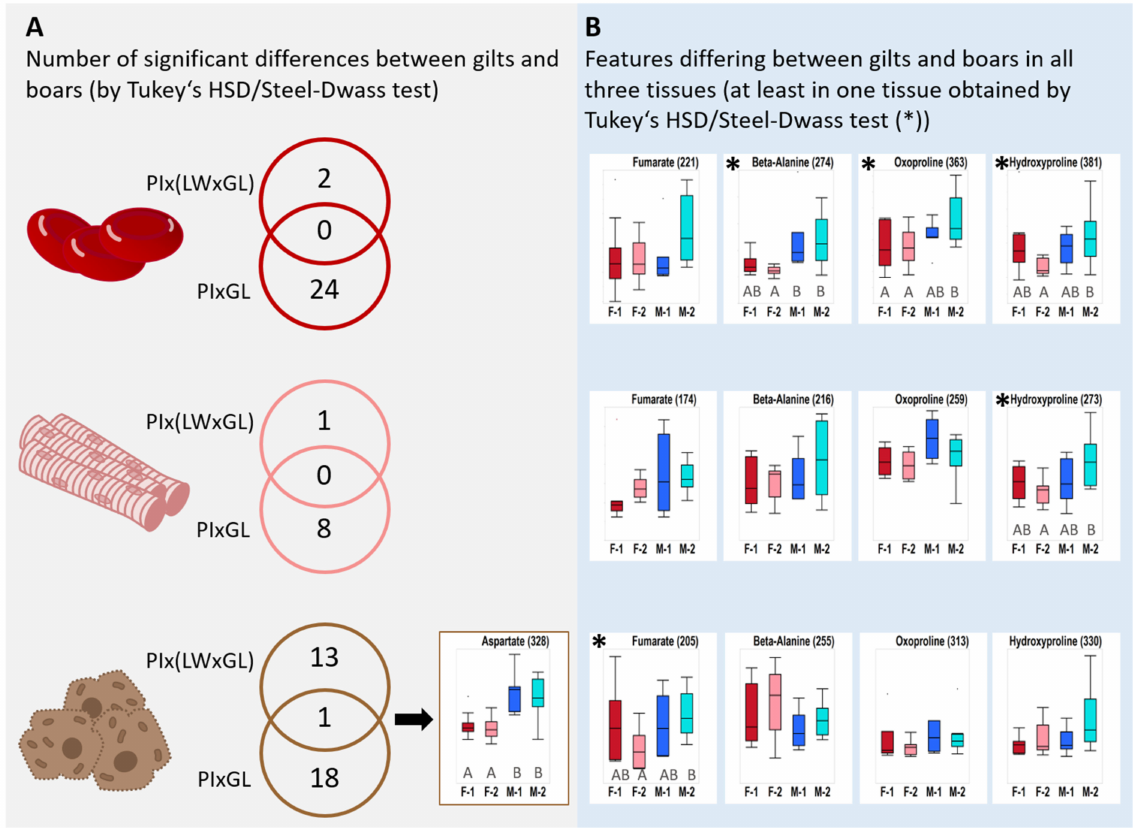
Figure 4. Gender-dependent differences in both genotypes. ( A ) Only significant analytes were summarized (obtained by Tukey’s HSD or Steel-Dwass testing); Aspartate is the only analyte significantly different in both genotypes. ( B ) Only those molecular features are illustrated in Box plots that were recorded in all three tissues as a candidate feature and showed at least in one tissue a significant difference (*). Significances (*) were only observed for the genotype PIxGL and are indicated with capital letters. No label means detected by VIP scoring and/or Student’s T-Test/Wilcoxon Test. The y -axis corresponds to total ion counts and is scaled to highlight the variation within and among groups. Abbreviations: F-1 = female PIx(LWxGL), F-2 = female PIxGL, M-1 = male PIx(LWxGL), M-2 = male